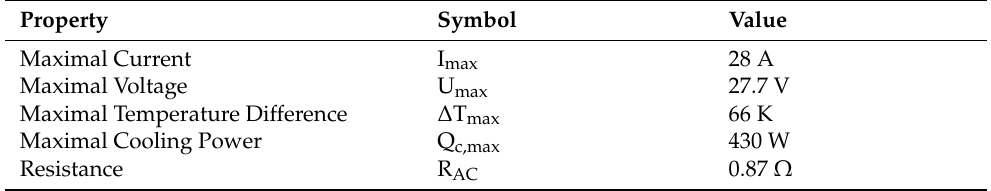
Table 1. Performance data of the selected thermoelectric modules at 25 ± 0.5 ◦ C test temperature. Property Symbol Value Maximal